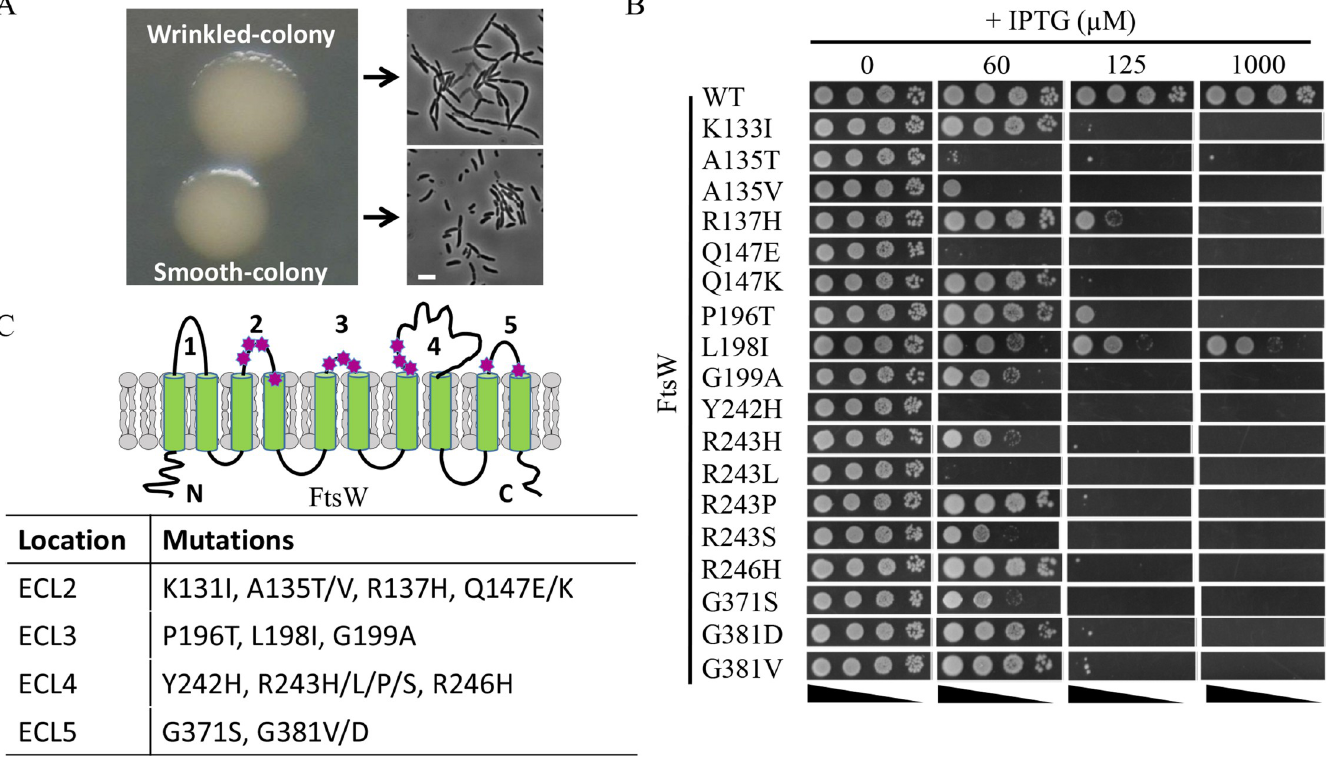
Fig 2. Isolation of dominant-negative FtsW mutants. (A) Wrinkled-colony-based screen for dominant-negative FtsW mutants. A plasmid library harboring mutagenized ftsW expressed from an IPTG-inducible promoter was transformed into strain JS238 and transformants selected on LB plates with ampicillin and 30 μ M IPTG. Most colonies were rounded and smooth, but a small percentage of colonies displayed a flat and wrinkled morphology. Inspection of the two types of colonies revealed that the wrinkled colonies consisted of chaining and filamentous cells. Scale bar, 3 μ m (B) Toxicity of dominant-negative FtsW mutants. Plasmids harboring the indicated alleles of ftsW were transformed into JS238 and transformants selected on LB plates with ampicillin and glucose. The spot test was performed as in Fig 1A. (C) Location of dominant-negative ftsW mutations in a topology model of FtsW. These mutations, indicated by a magenta heptagon, were clustered in ECL2, ECL3, ECL4 and ECL5 of